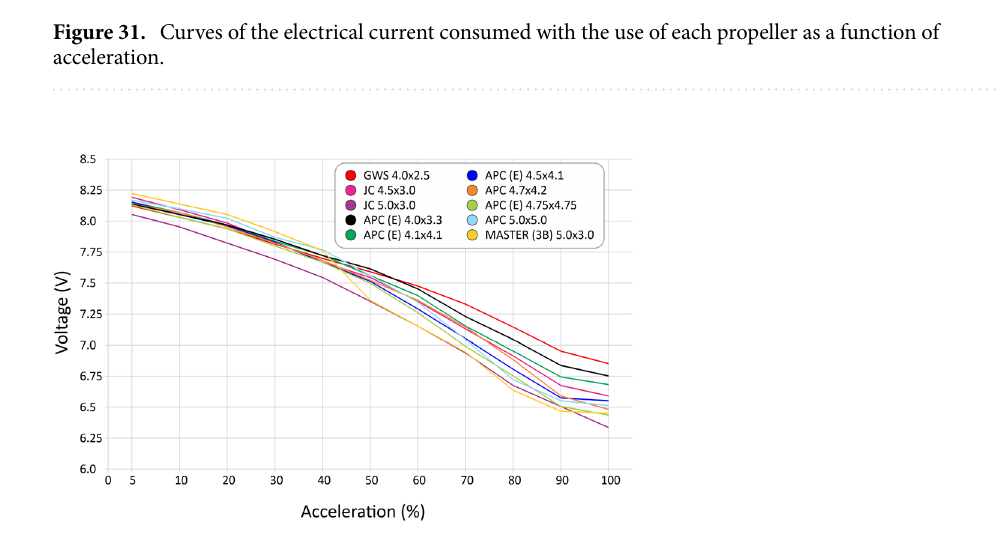
Figure 32. Voltage curves available by the battery with the use of each propeller as a function of